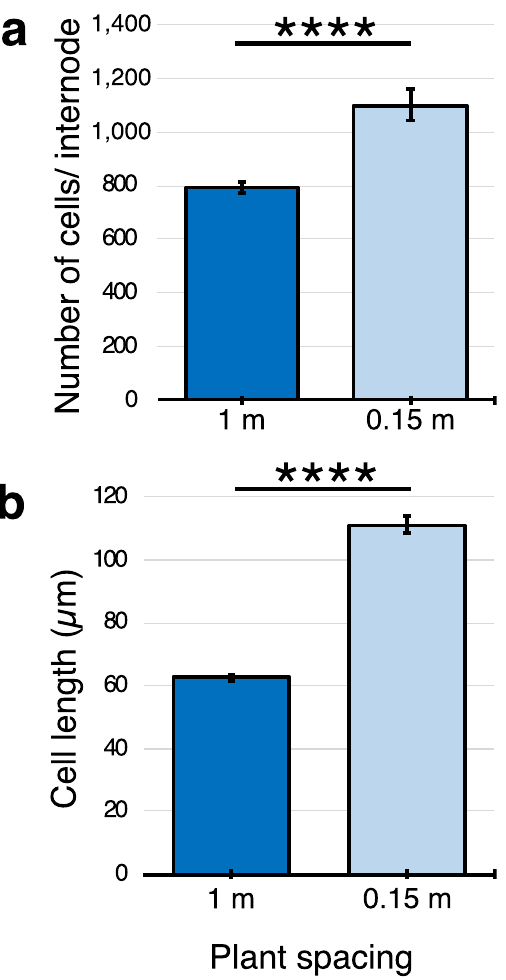
Figure 3. Plant spacing affects the number and length of cells in sorghum internodes. ( a ) The average number of cells spanning fully elongated internodes of phytomer 7 and ( b ) average length of cells in phytomer 7 of plants grown at 1 m and 0.15 m spacing. Asterisks indicate two-tailed P value, ****P < 0.0001, by Welch’s t test [n = 96 (1 m), n = 84 (0.15 m)]. Error bars: